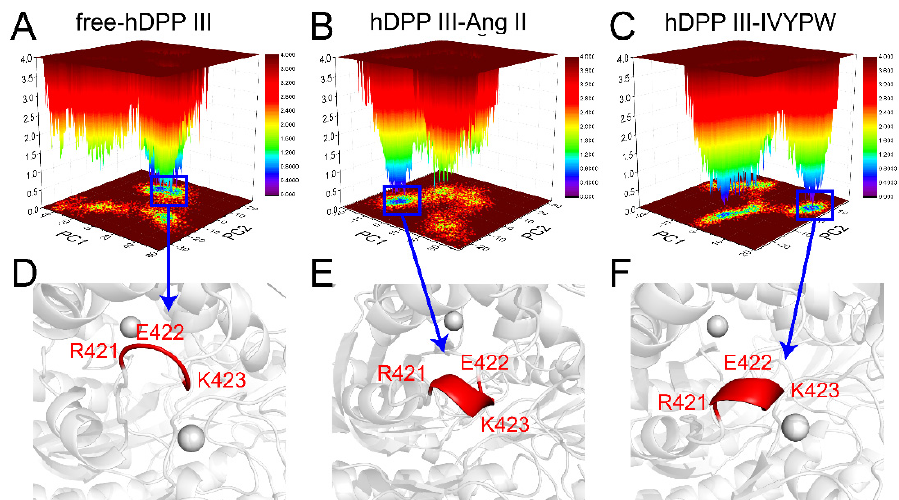
Figure 11. PCA-based FEL analysis of hDPP III. ( A – C ) Free-hDPP III, hDPP III–Ang II, and hDPP III–IVYPW as a function of the projections of the MD trajectory onto the first (PC1) and second (PC2) eigenvectors. ( D – F ) The structures of the most stable conformations of the three systems are presented with the conformation of Arg421-Lys423 colored in red. Table 3. The probabilities of PC1 and PC2 of the three systems.